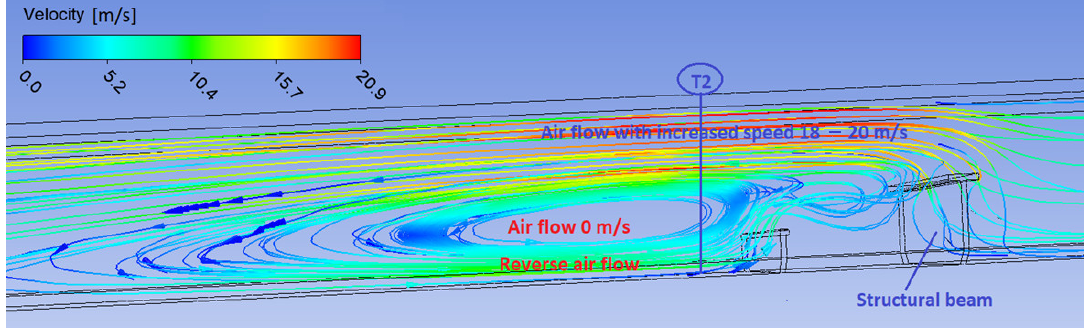
Figure 10. Streamlines; CFD model with a beam size of 288 mm without deflectors.